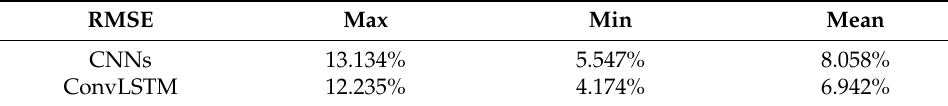
Table 4. Comparison of the RMSE between the CNNs and ConvLSTM.